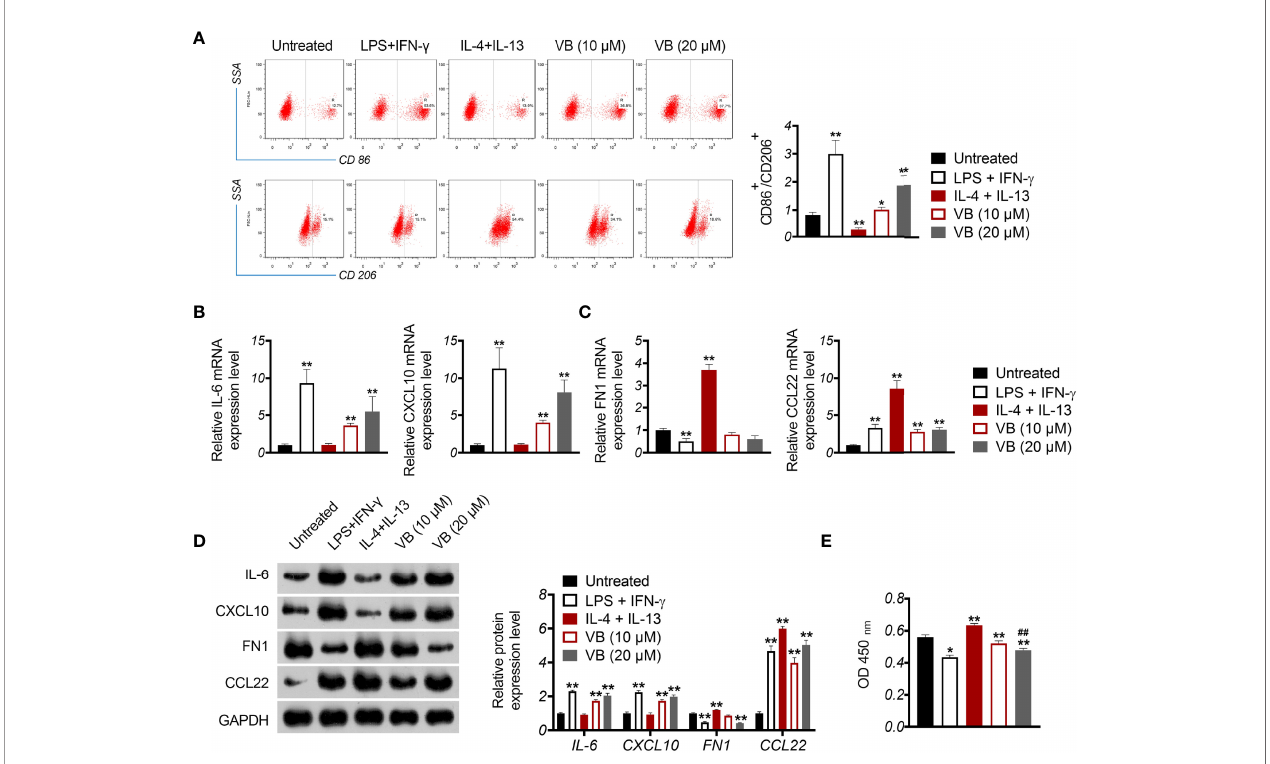
FIGURE 2 | VB promotes M1 macrophage polarization in OC cells. (A) The CD86 + and CD206 + ratio in macrophages were measured by fl ow cytometry. (B, C) The relative mRNA expression levels of IL6, CXCL10, FN1, and CCL22 were examined by RT-qPCR. (D) The relative protein expression of IL6, CXCL10, FN1, and CCL22 was measured by Western blotting. (E) The proliferation of A2780 cells was detected by CCK8 assay. A2780 cells were co-cultured with THP-1 macrophage and treated with LPS + IFN- g , IL-4 + IL-13, 10 µM VB, or 20 µM VB. Each trial was replicated at least three times. Data are expressed as the mean ± SD; * P < 0.05 and ** P < 0.01 vs. the untreated group; ## P < 0.01 vs. the VB (10 µM)